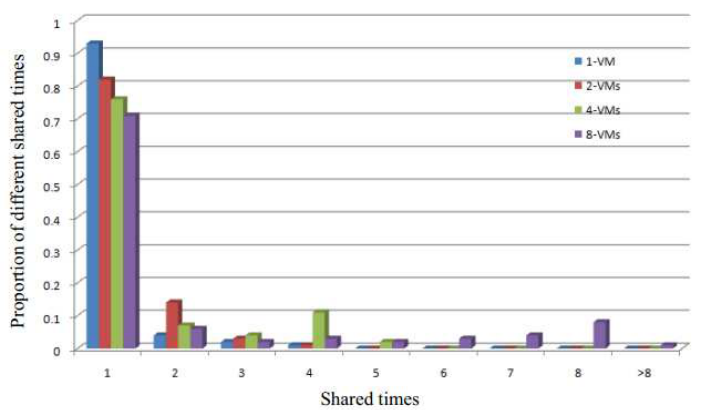
Figure 9. The proportion of physical pages for different shared